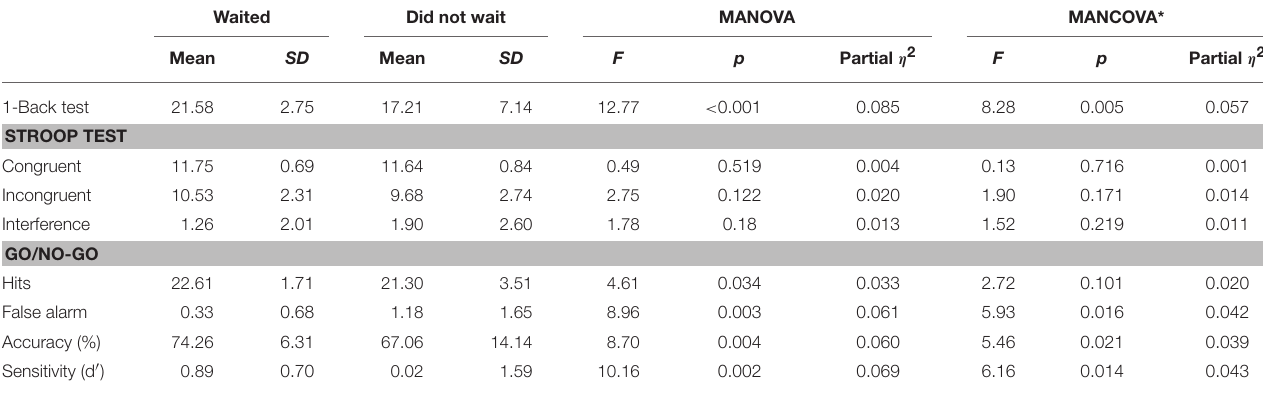
TABLE 2 | Descriptive statistics, MANOVA, and MANCOVA on measures of executive function ability between groups. Waited Did not wait MANOVA MANCOVA * Mean SD Mean SD F p Partial η 2 F p Partial η 2